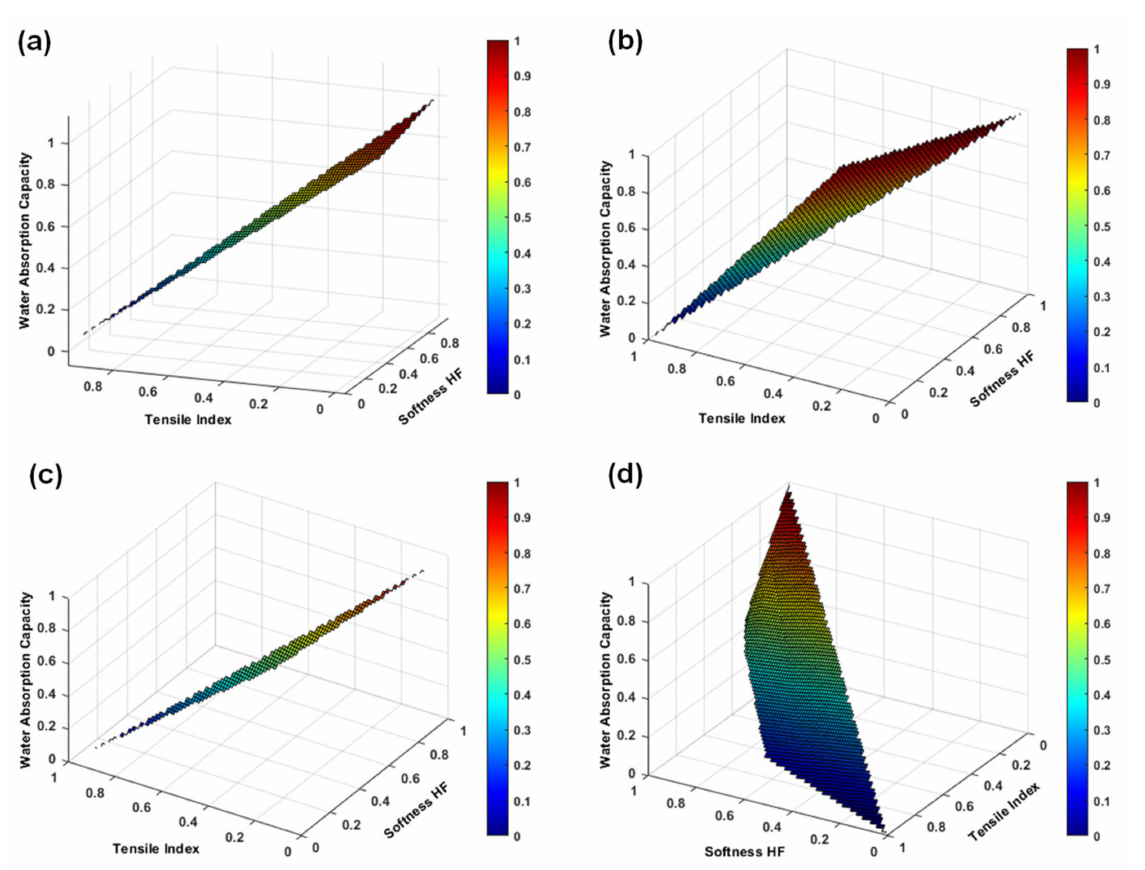
Figure 9. Evolution and prediction of softness HF, tensile index, and water absorption capacity from F1 and F2 ( a ), F3 and F4 ( b ), F5 and F6 ( c ), and F7 to F9 ( d ). The variables were